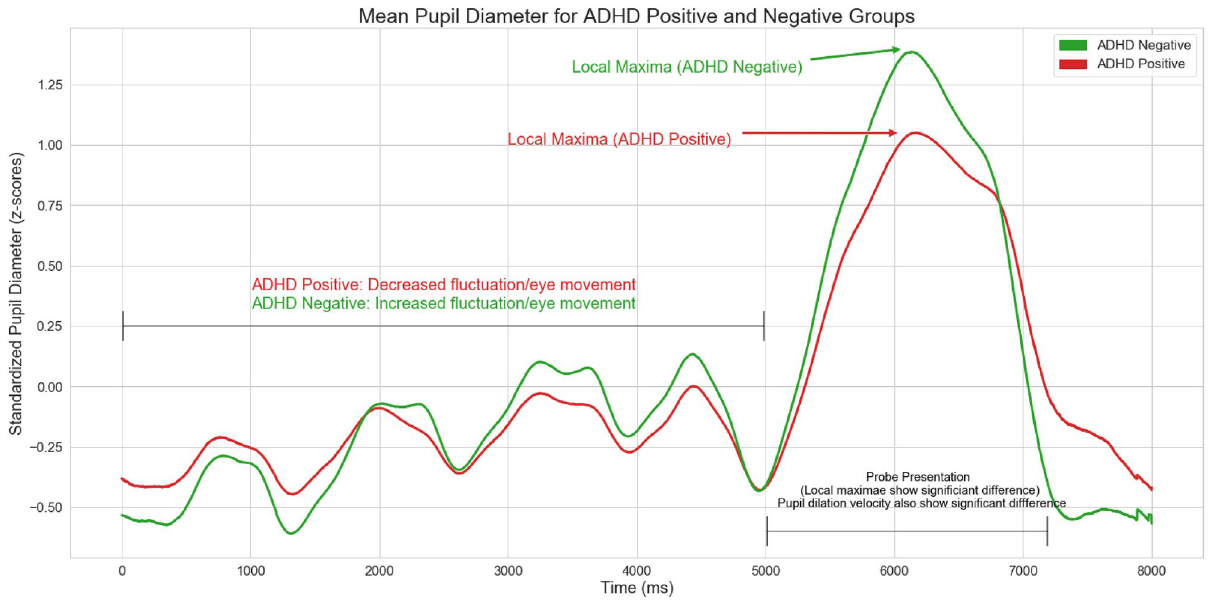
Figure 1. Time-series visualization of the mean pupil diameter averaged across multiple trials, grouped by ADHD